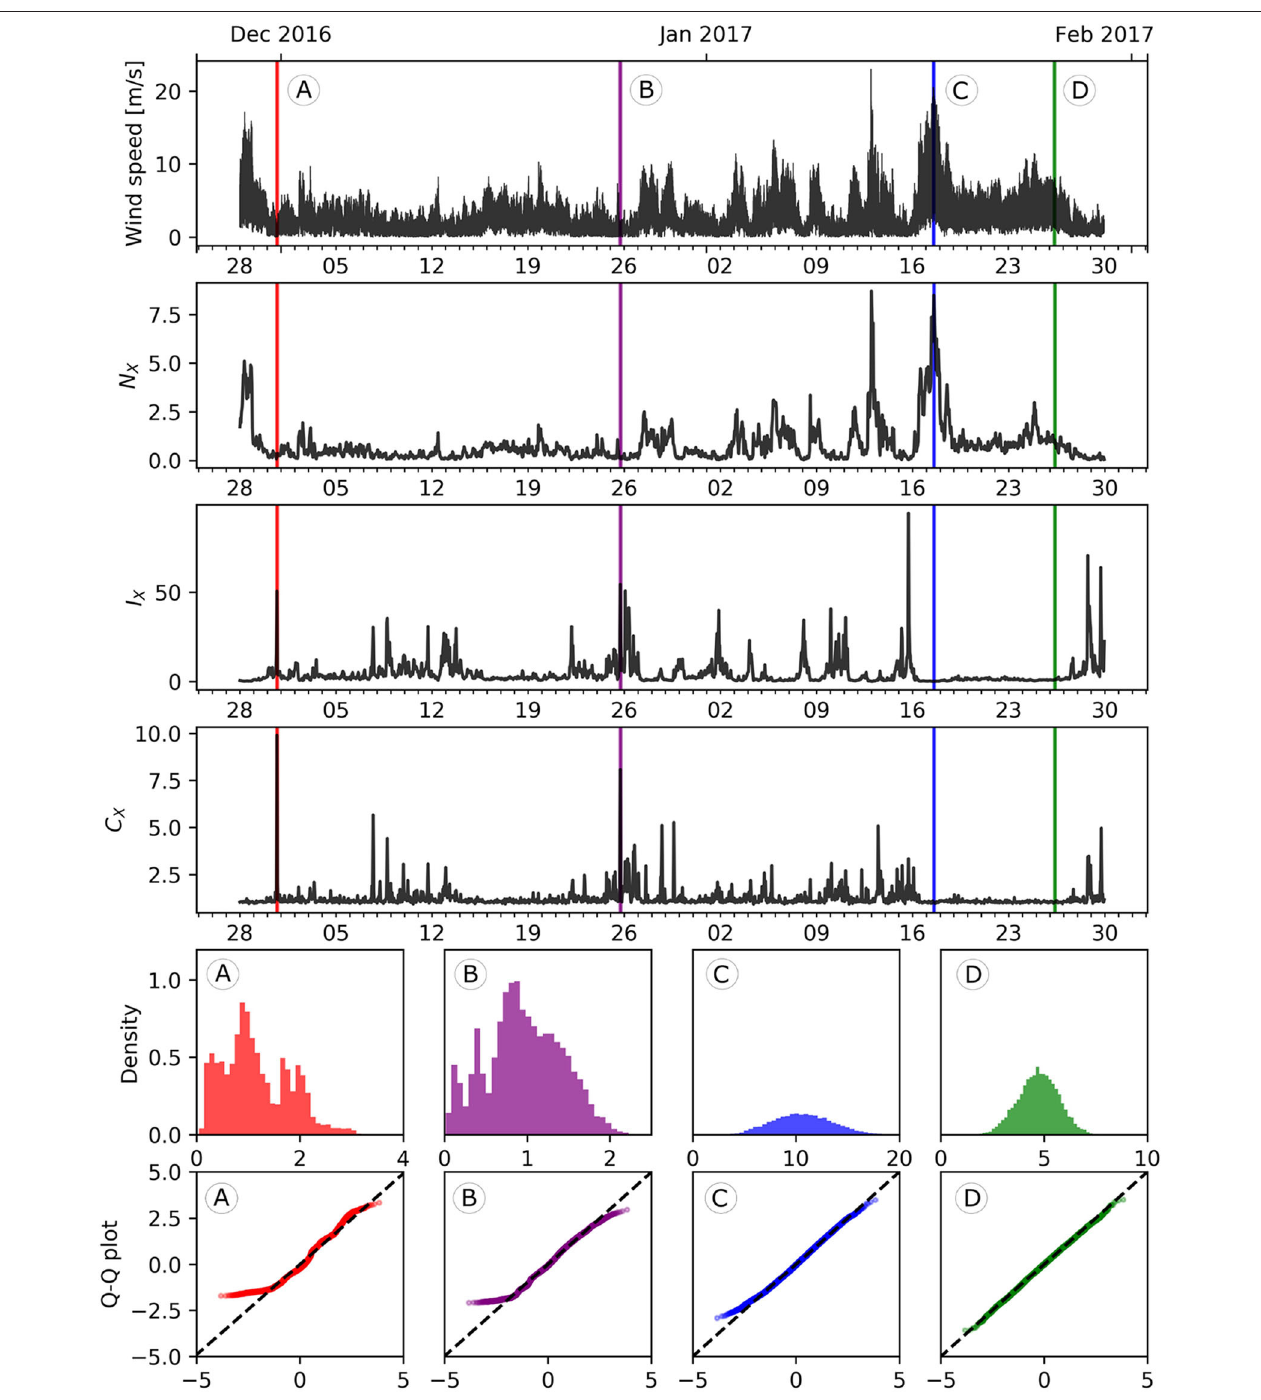
FIGURE 4 | High-frequency wind speed time series. From top to bottom : time series, SEP, FIM, and FSC moving windows, histograms and Q-Q plots of some time series subsets.